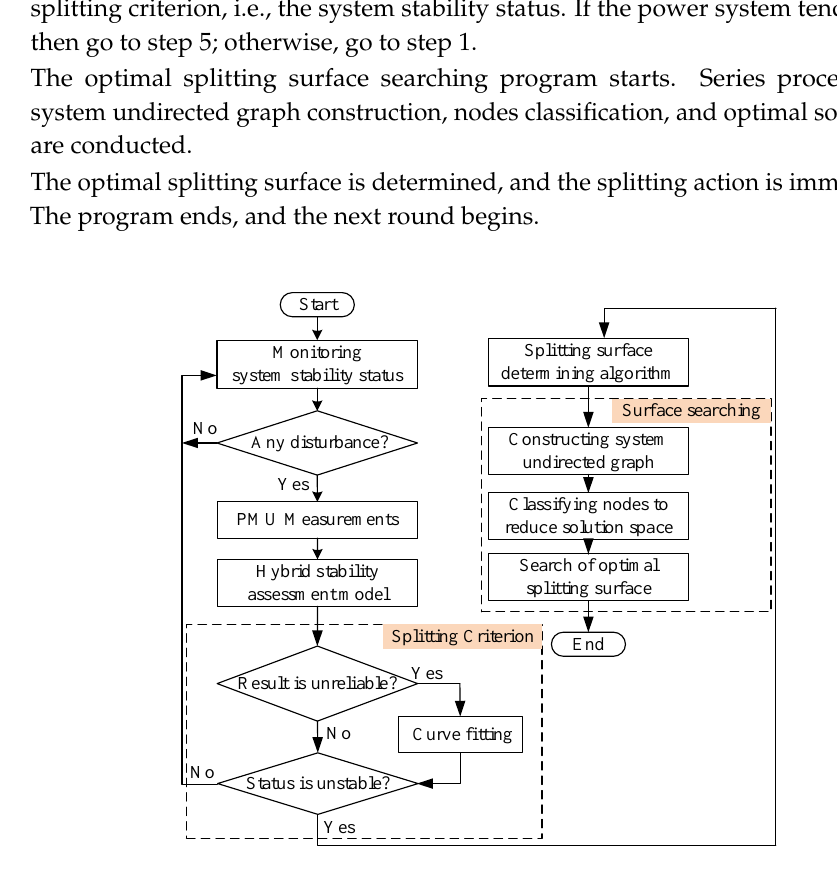
Figure 5. Flowchart of the proposed controlled islanding implementation strategy.